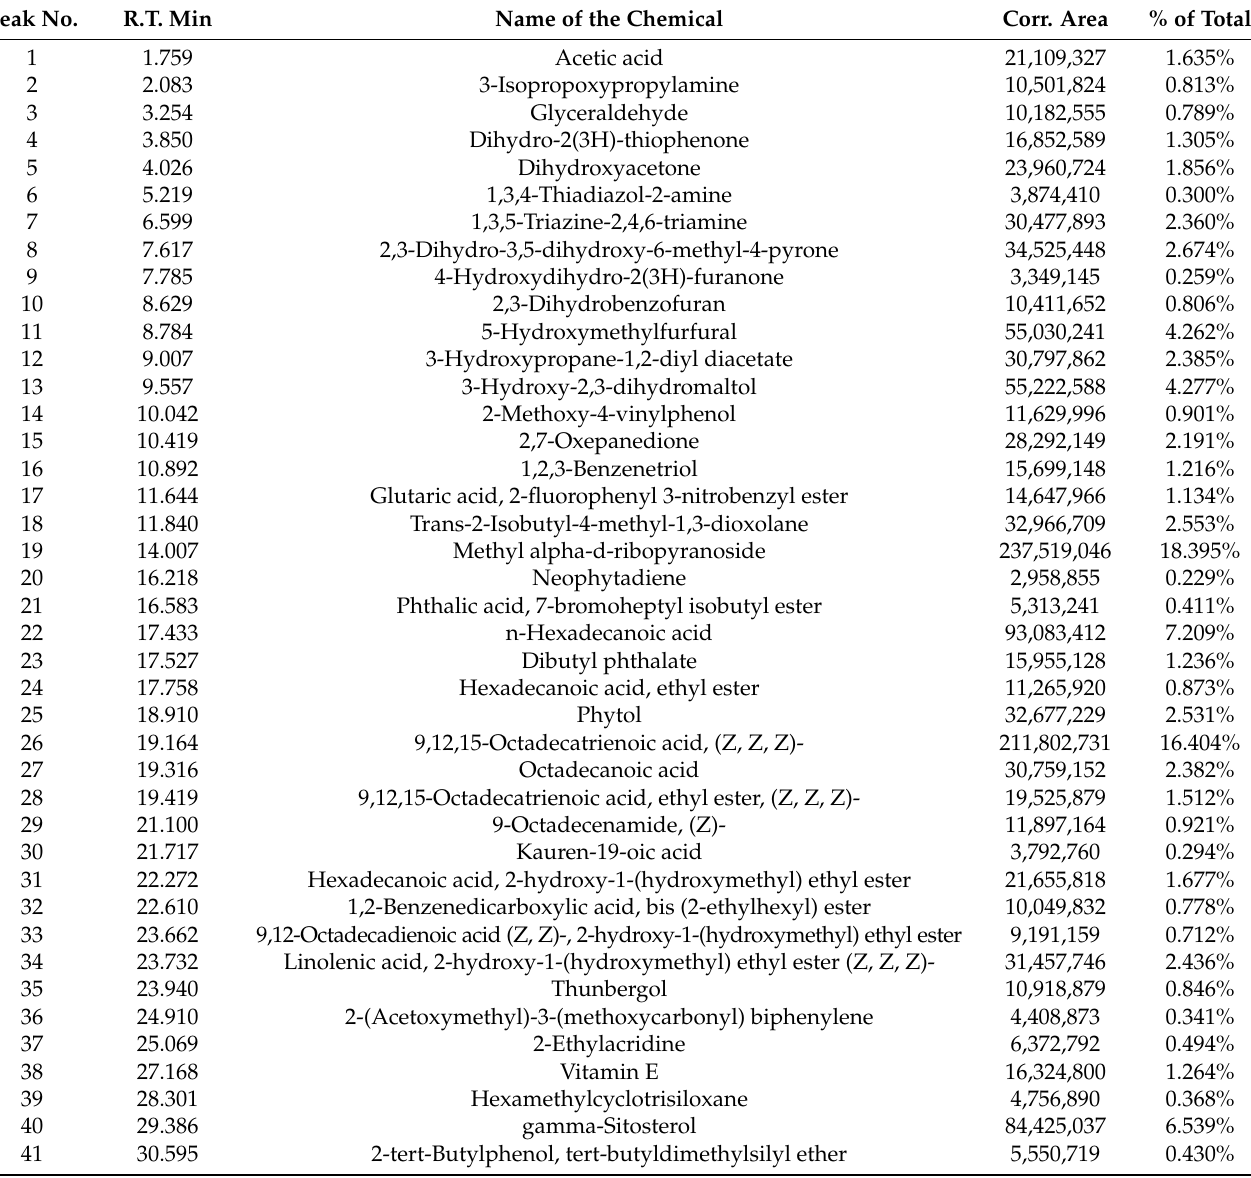
Table 1. Phytochemical analysis of Pp-EE by